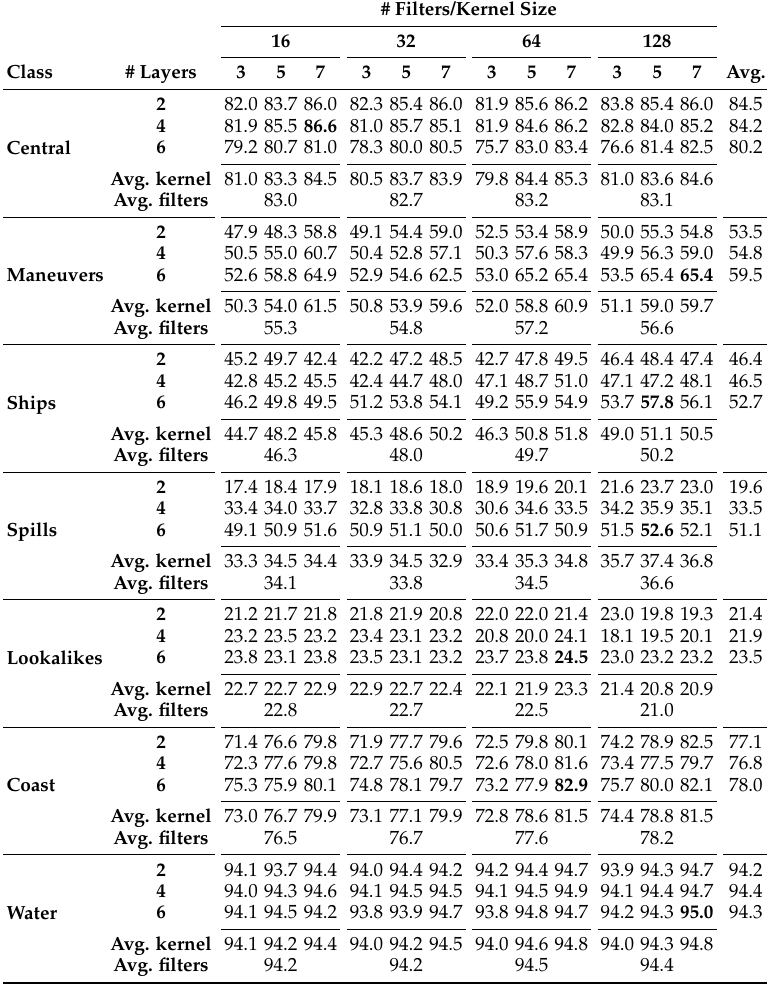
Table 3. Results ( F 1 %) of the grid-search process to determine the number of layers, filters and kernel size of each of the CMSAE networks. In addition, the average results obtained are included and the best result for each class is marked in